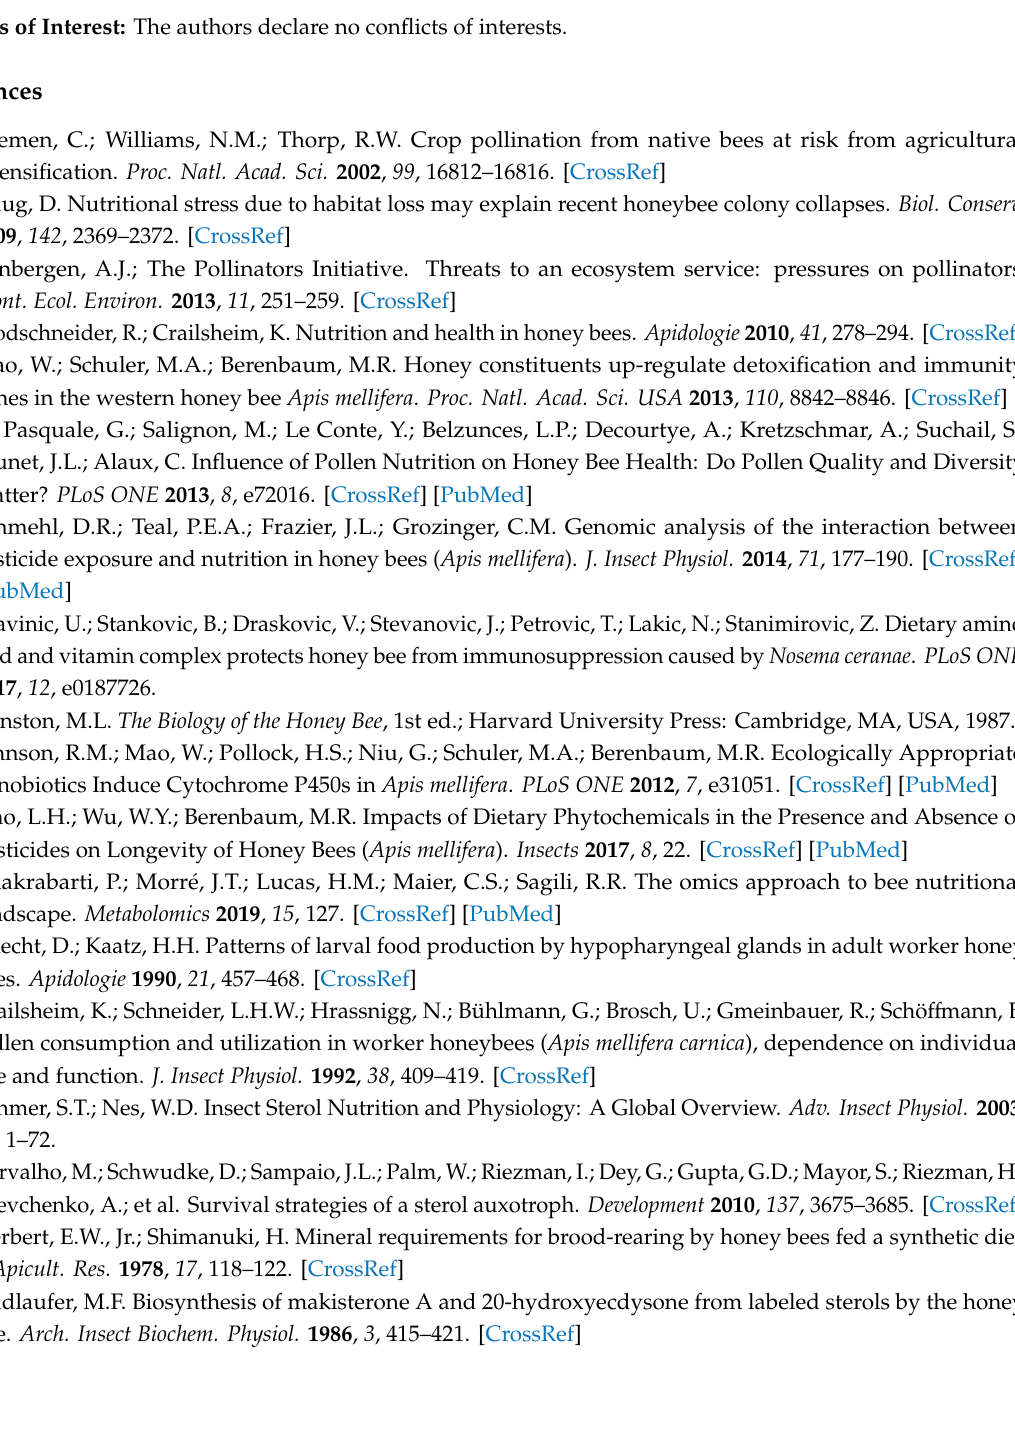
bee), Table S5: 13 C contents of the three tissue types from the sterol-supplemented group are provided across four